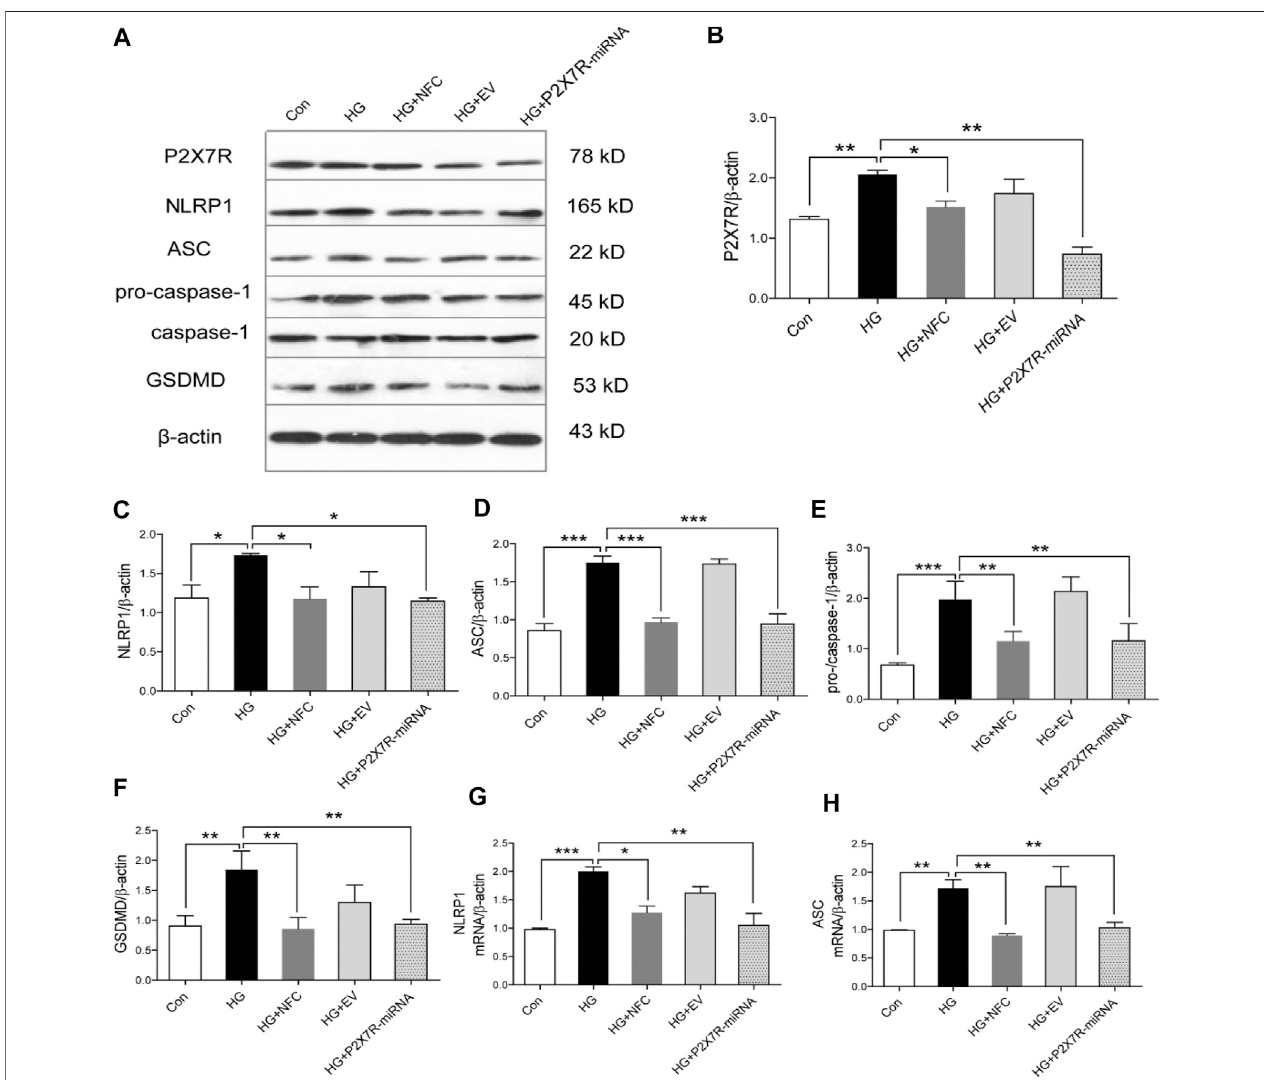
FIGURE4| NaofucongsuppressedP2X7-inducedneuronalinjuryinhighglucose-inducedHT22hippocampalneuroncells. (A) EffectsofNFConP2X7R,NLRP1, ASC, pro-caspase-1, caspase-1, and GSDMD levels of HT22 cells in high glucose. (B – F) Representative protein levels of P2X7R, NLRP1, ASC, pro-caspase-1, caspase-1, and GSDMD levels of HT22 cells in high glucose were assessed by western blotting using speci fi c antibodies. (G, H) Effects of NFC and P2X7R-miRNA on NLRP1 and ASC mRNA levels of HT22 cells in high glucose. Values are means ± SEM, n (cid:2) 4 per group, * p < 0.05, ** p < 0.01, *** p < 0.001.